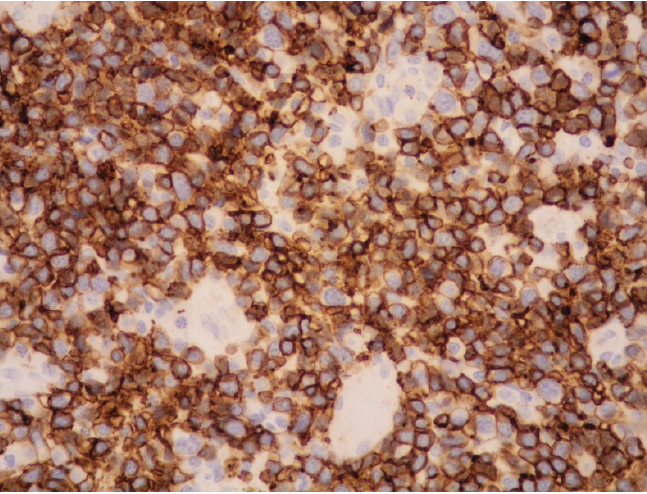
Figure 7. High-power view showing a diffuse proliferation of CD56-positive atypical cells (CD56 immunostaining, 200× magnification, previously unpublished, original image from S.A.).